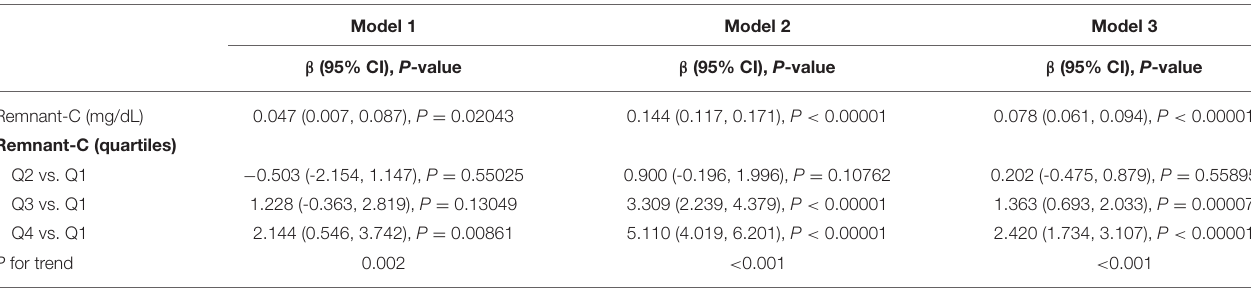
Model 1 adjust for: none. Model 2 adjust for: gender, age, race. Model 3 adjust for: gender, age, race, body mass index, systolic blood pressure, diastolic blood pressure, hypertension treatment, smoking, diabetes, low density lipoprotein cholesterol. Remnant-C, remnant cholesterol; CI, confidence